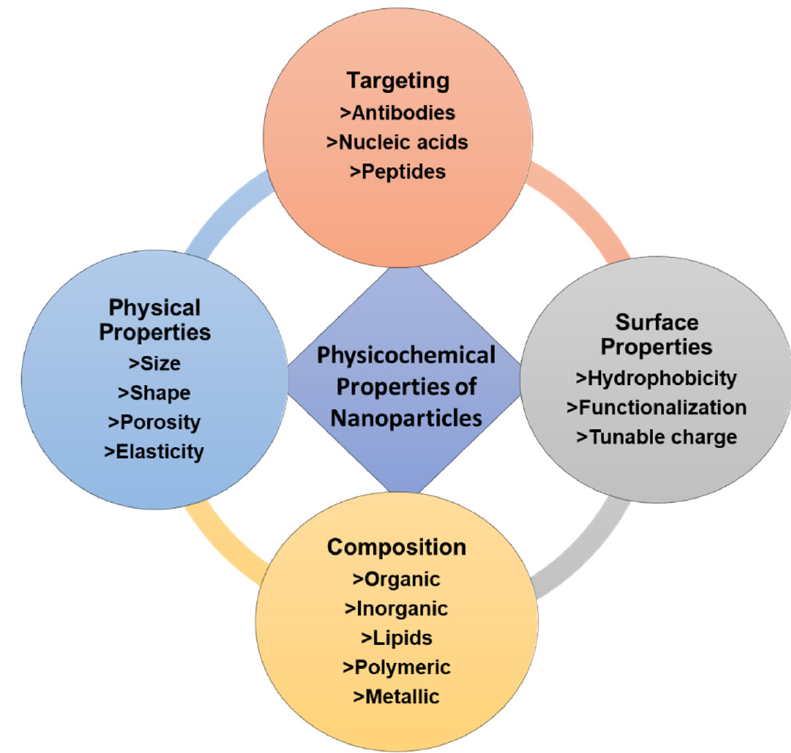
Figure 4. Summary of the tunable physicochemical properties of nanoparticles. NPs protect the therapeutic agent from opsonization and premature